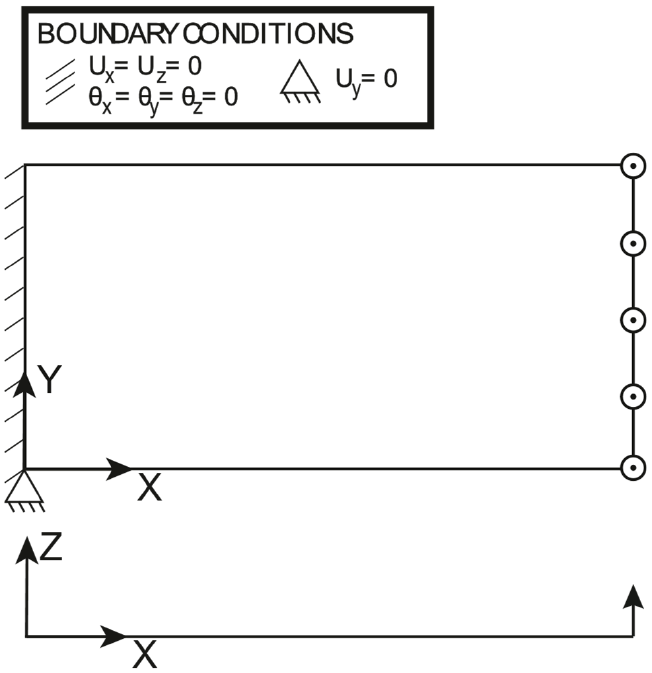
Figure 9. Out-of-plane tip loading: loading and boundary conditions. Table 3 . Out-of-plane tip loading: selected polynomial pre-extrapolation orders.